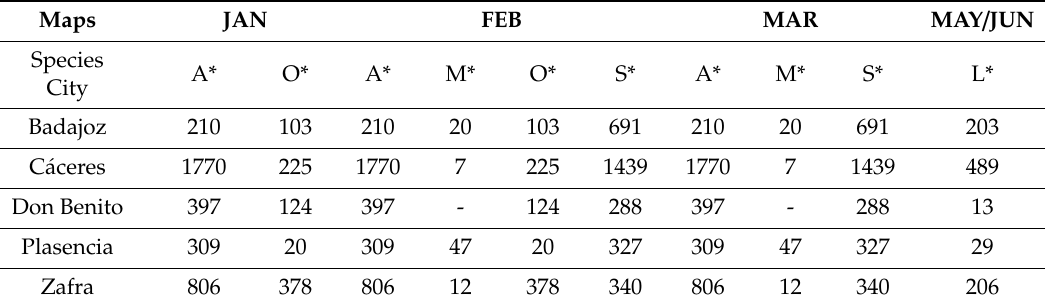
Table 5. Number of points (specimens) taken for each map and